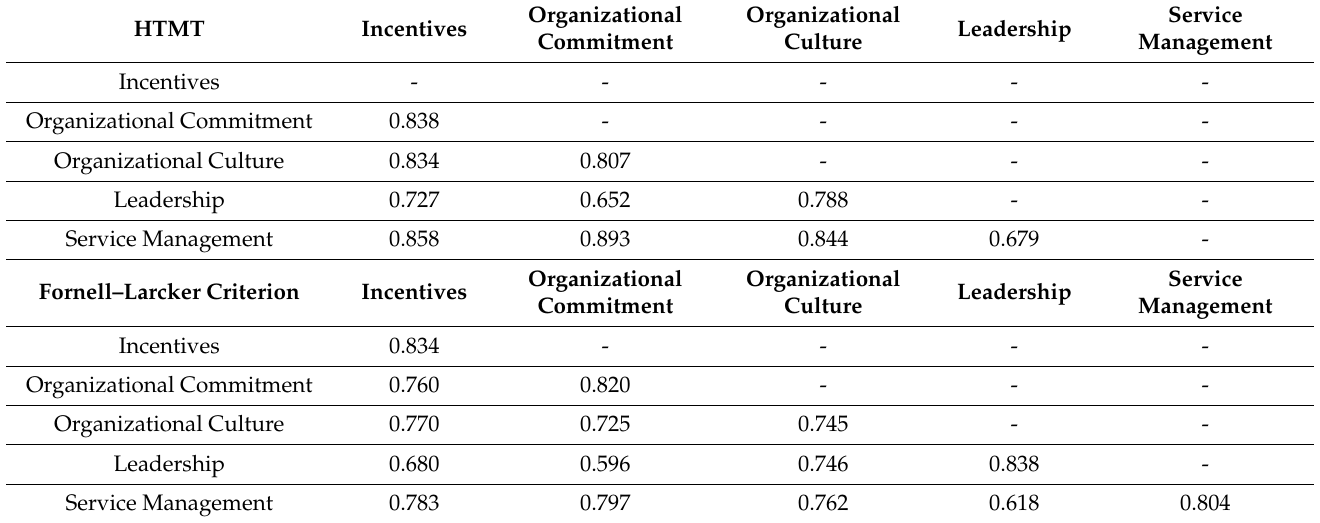
Table 4. HTMT and Fornell–Larker